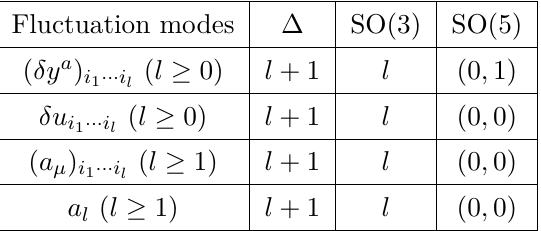
Table 2. In this table we summarize the quantum numbers of the operator dual to each fluctuation mode. ∆ gives the conformal dimension of the dual operator. The quantum numbers of the dual operator under SO(3) and SO(5) symmetry are given in terms of the Dynkin labels of the corresponding